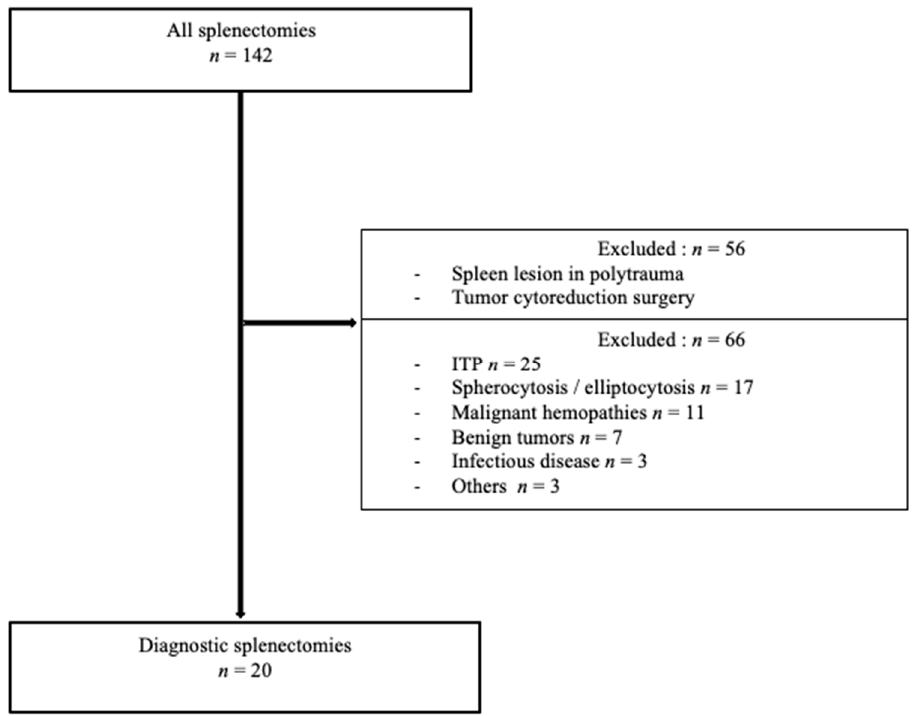
Figure 1. Flow chart. ITP, immune thrombocytopenic purpura.